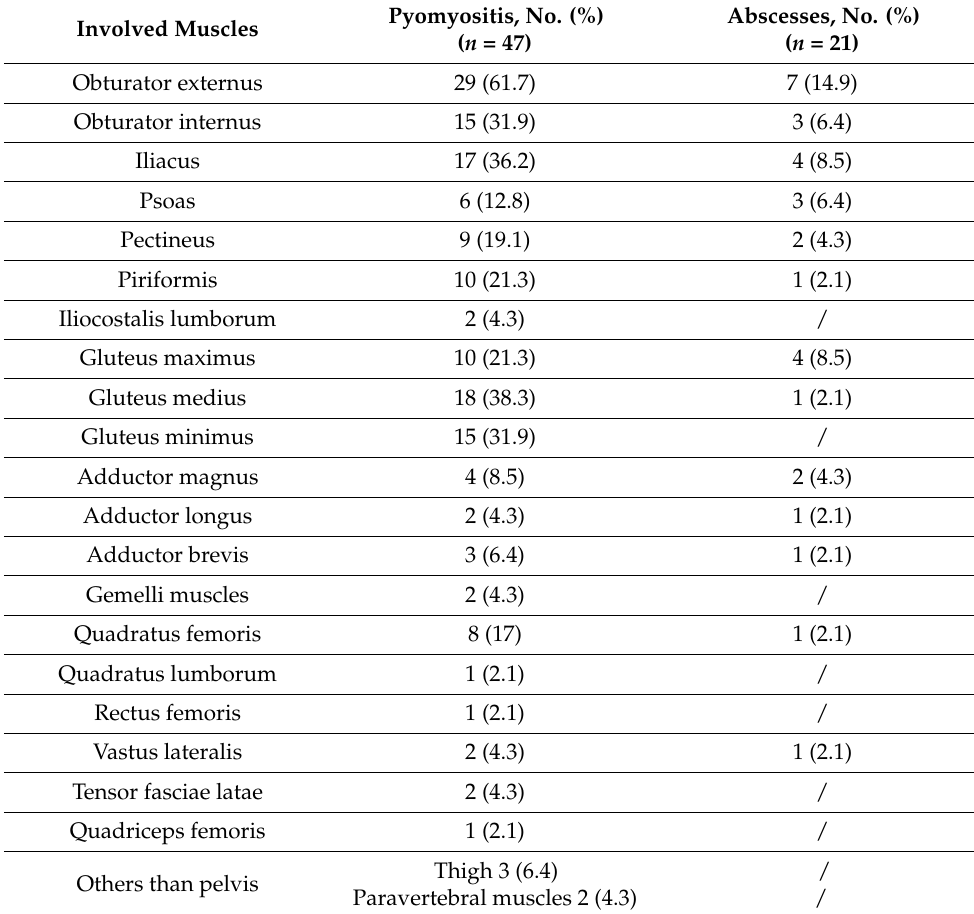
Table 2. Pelvic girdle involvement in our 47 patients affected by pyomyositis. Pyomyositis, No. Involved Muscles